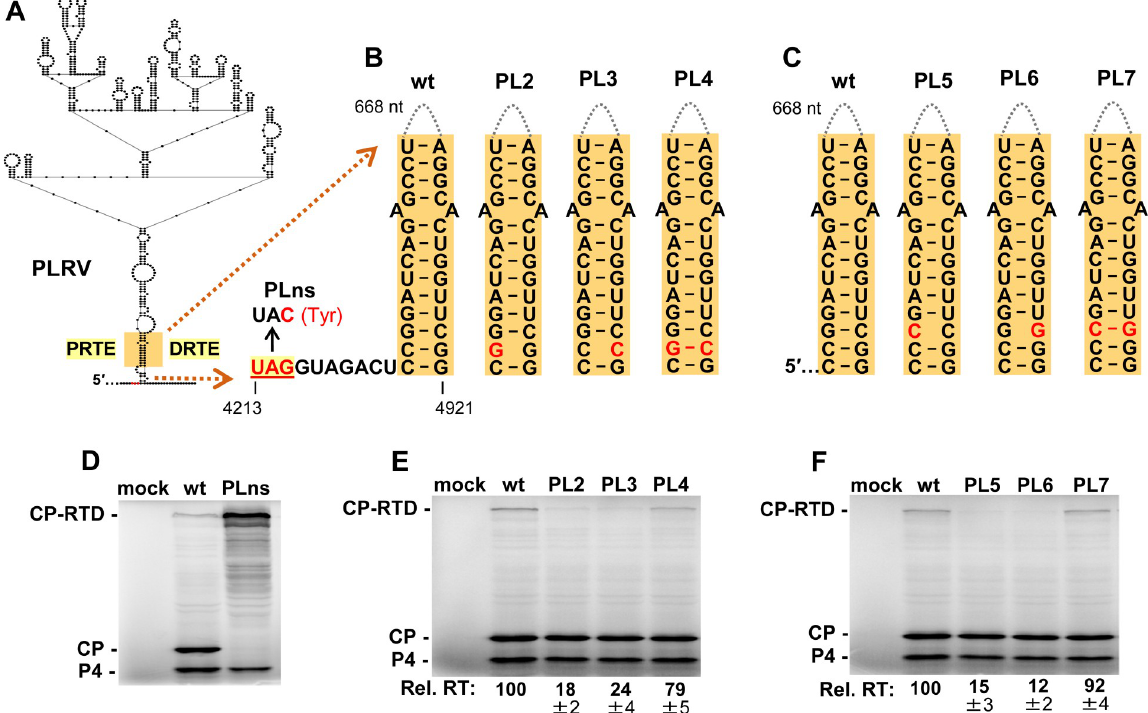
Fig 8. Assessing the PRTE/DRTE interaction in PLRV. (A) RNA secondary structure model for a central region of the PLRV sg mRNA based on RNAStructure [34] and rendered using RNA2Drawer [57]. In the structure, small black circles represent nucleotides, with those corresponding to the PLRV CP UAG stop codon shown in red. Highlighted in orange are the PRTE and DRTE sequences previously proposed to base-pair and regulate CP readthrough in PLRV [13]. (B) and (C) Compensatory mutations introduced in PLRV sg mRNA that target the orange PRTE/DRTE base-pairing interaction, and mutant PLns, in which the CP stop codon was inactivated. (D) , (E) and (F) In vitro translation analyses of the wt and mutant PLRV sg mRNAs shown in panels B and C. Averaged Rel. RT levels ( ± SE) collected from three independent trials are shown below each